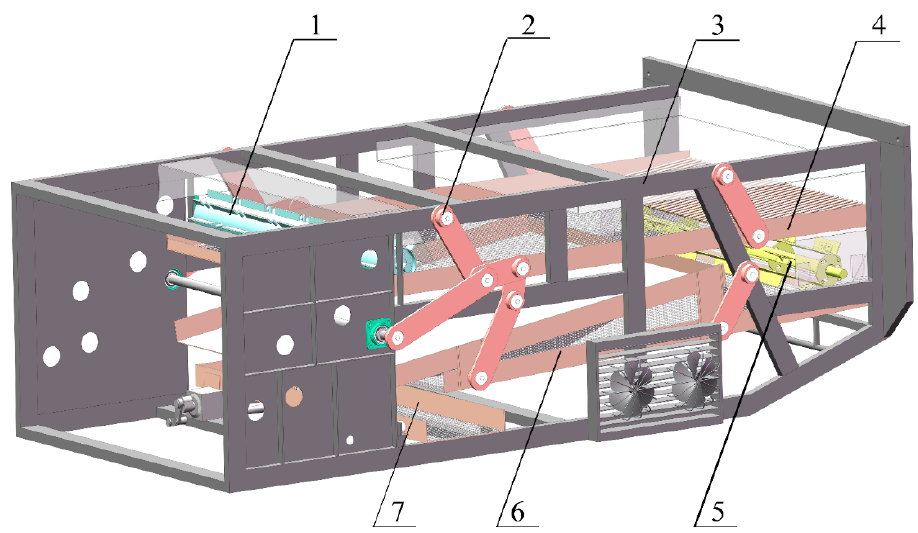
Figure 1. Self-propelled harvester of tiger nuts. 1. Cab 2. Grain bin 3. Squeegee lift conveyer 4. Sieving device 5. Crawler traveling device 6. Secondary lifting device 7. Digging device.